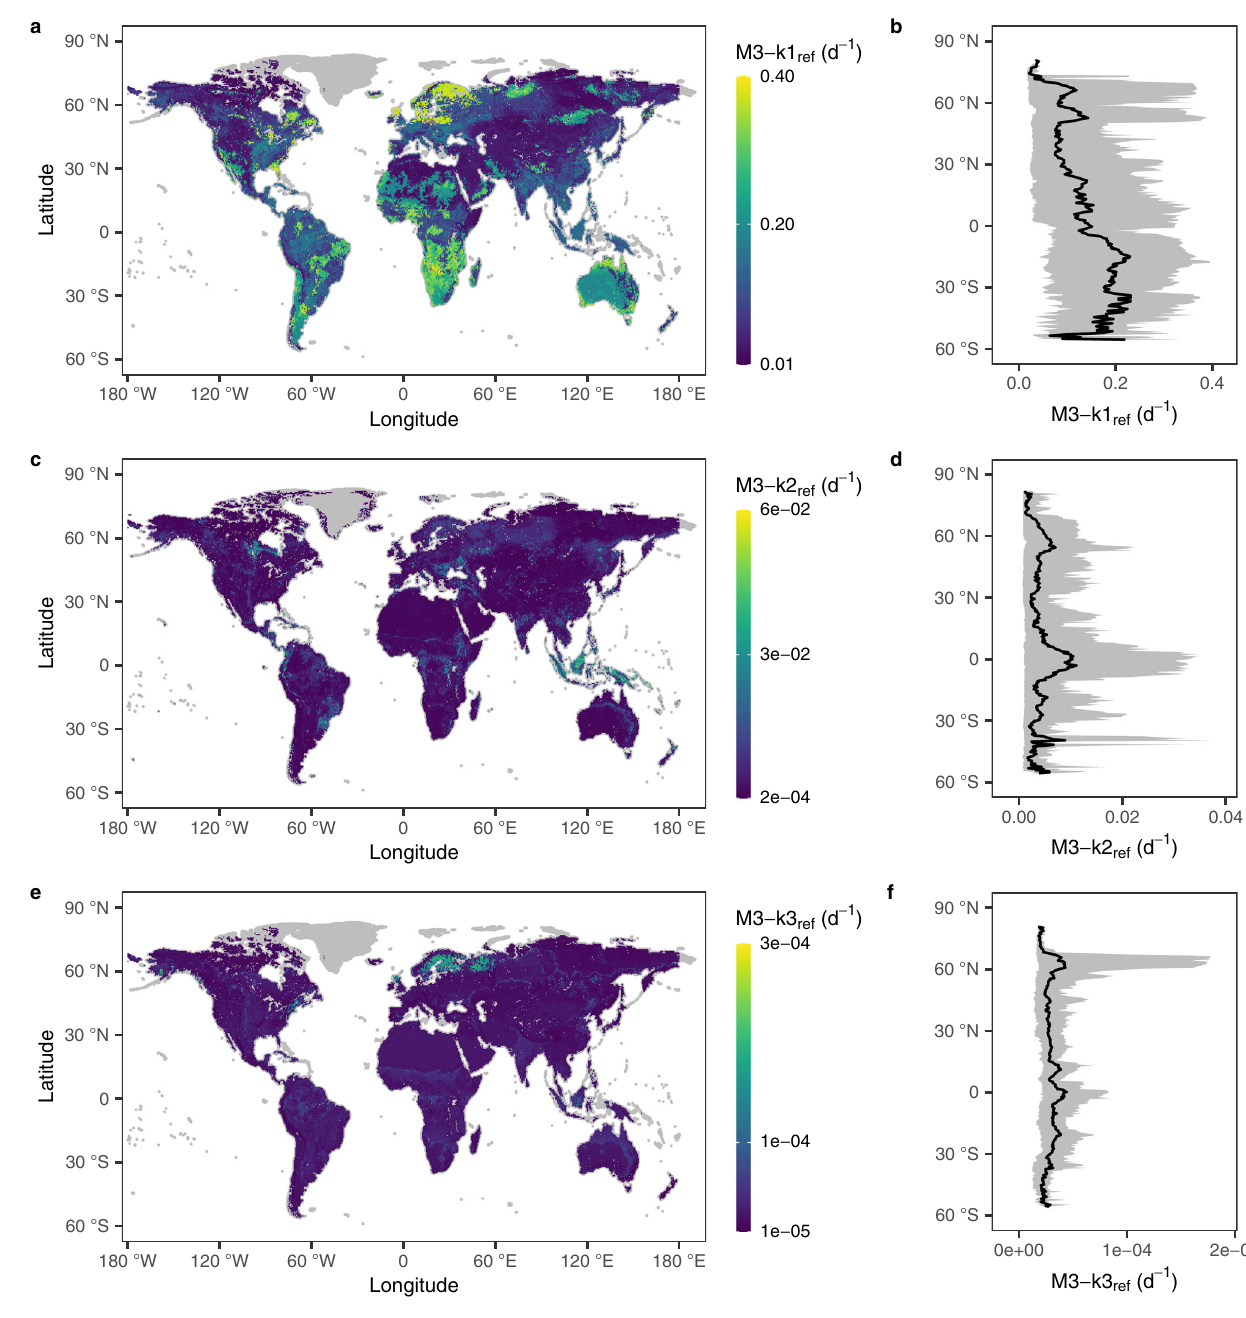
Fig. 4 | Global distribution and latitudinal pattern of the reference decom- position rates (k ref ) of the three soil organic matter (SOM) pools predicted by the Random Forest (RF) model with feature selection. a, b fast pool (M3-k1 ref